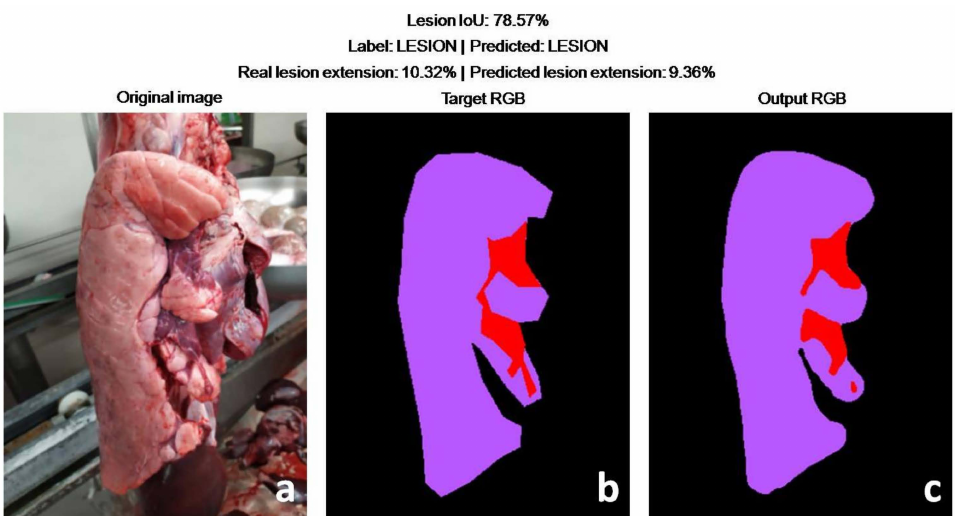
Figure 9. Test set. Diseased lung. Pictures ( a , b ) represent the original picture and the annotation of the veterinarian, respectively. In detail, the veterinarian-annotated lung (purple) and lesion (red). The prediction of the DLBM ( c ) largely, although not perfectly, fits with the VAs ( b ). As shown by the original pictures ( a ), the shape of the EP-like lesion is irregular, due to the presence of fissures and intermingling emphysematous lobules. Notably, the DLBM also well-predicted a long cut (artifact) in the diaphragmatic